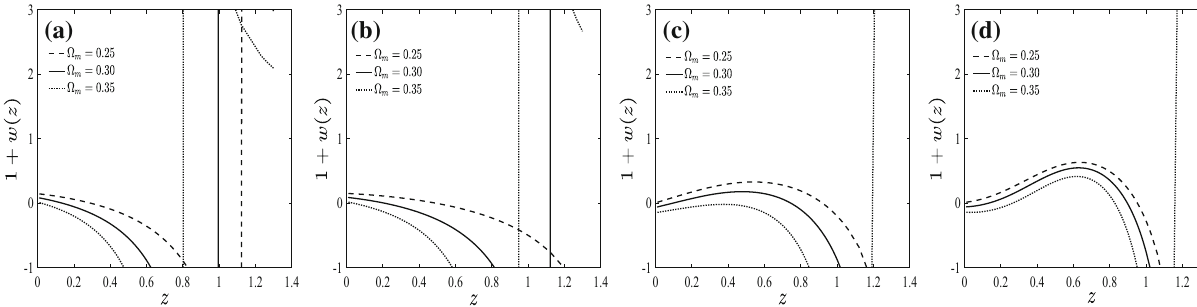
Fig. 9 Cosmographic EoS for different orders with matter density (cid:7) m = 0 . 25 , 0.30 and 0.35, respectively